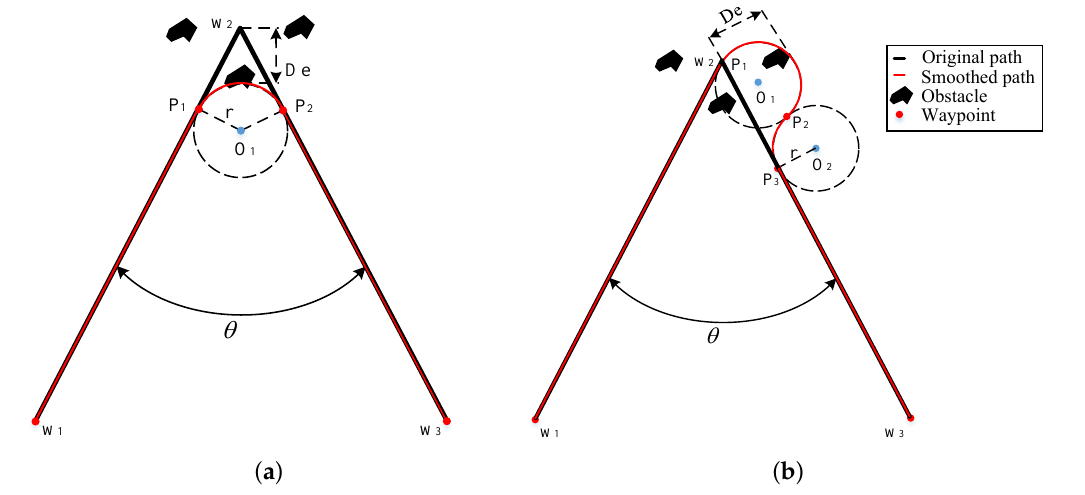
Figure 3. Smoothed paths: ( a ) Created by using one Dubins curve. ( b ) Created by using two Dubins curves.